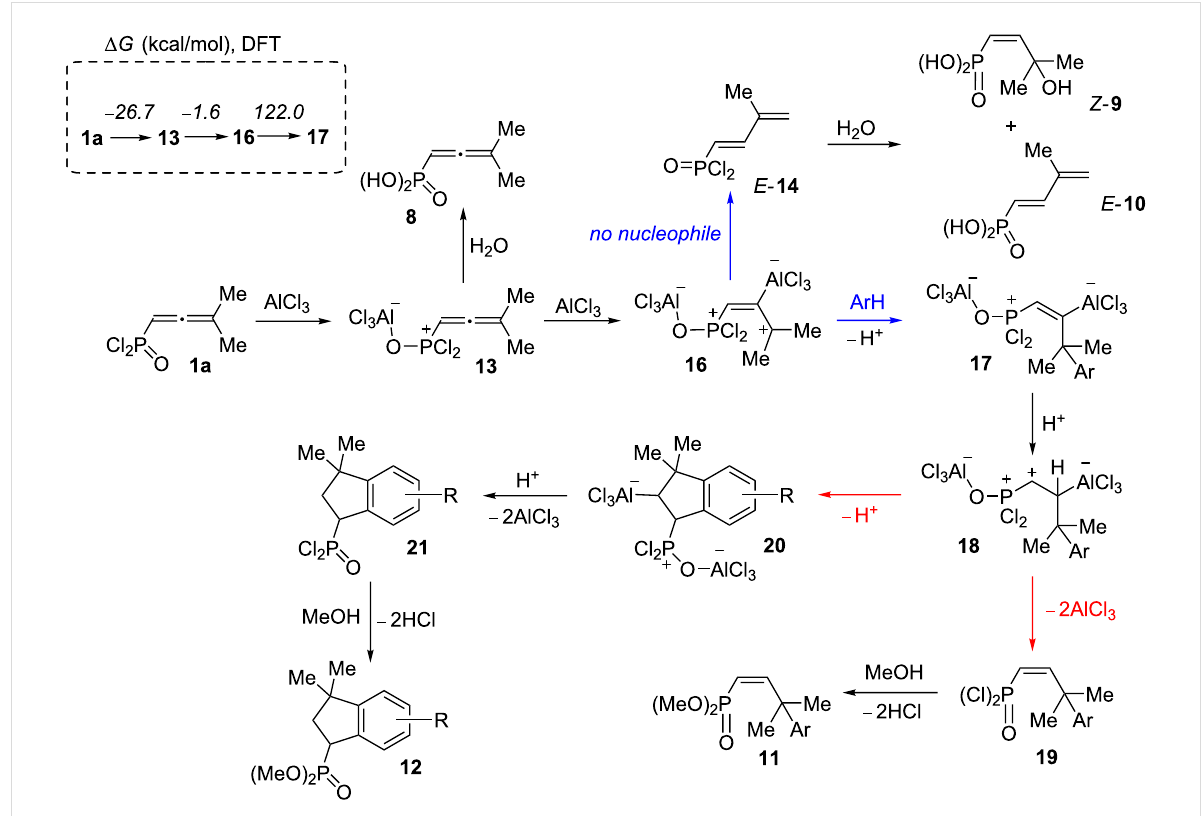
Scheme 9: Plausible reaction mechanism A for the formation of compounds 9 , 10 , 11 , 12 from aillene 1a involving AlCl 3 attack on the central atom of allenic complex 13